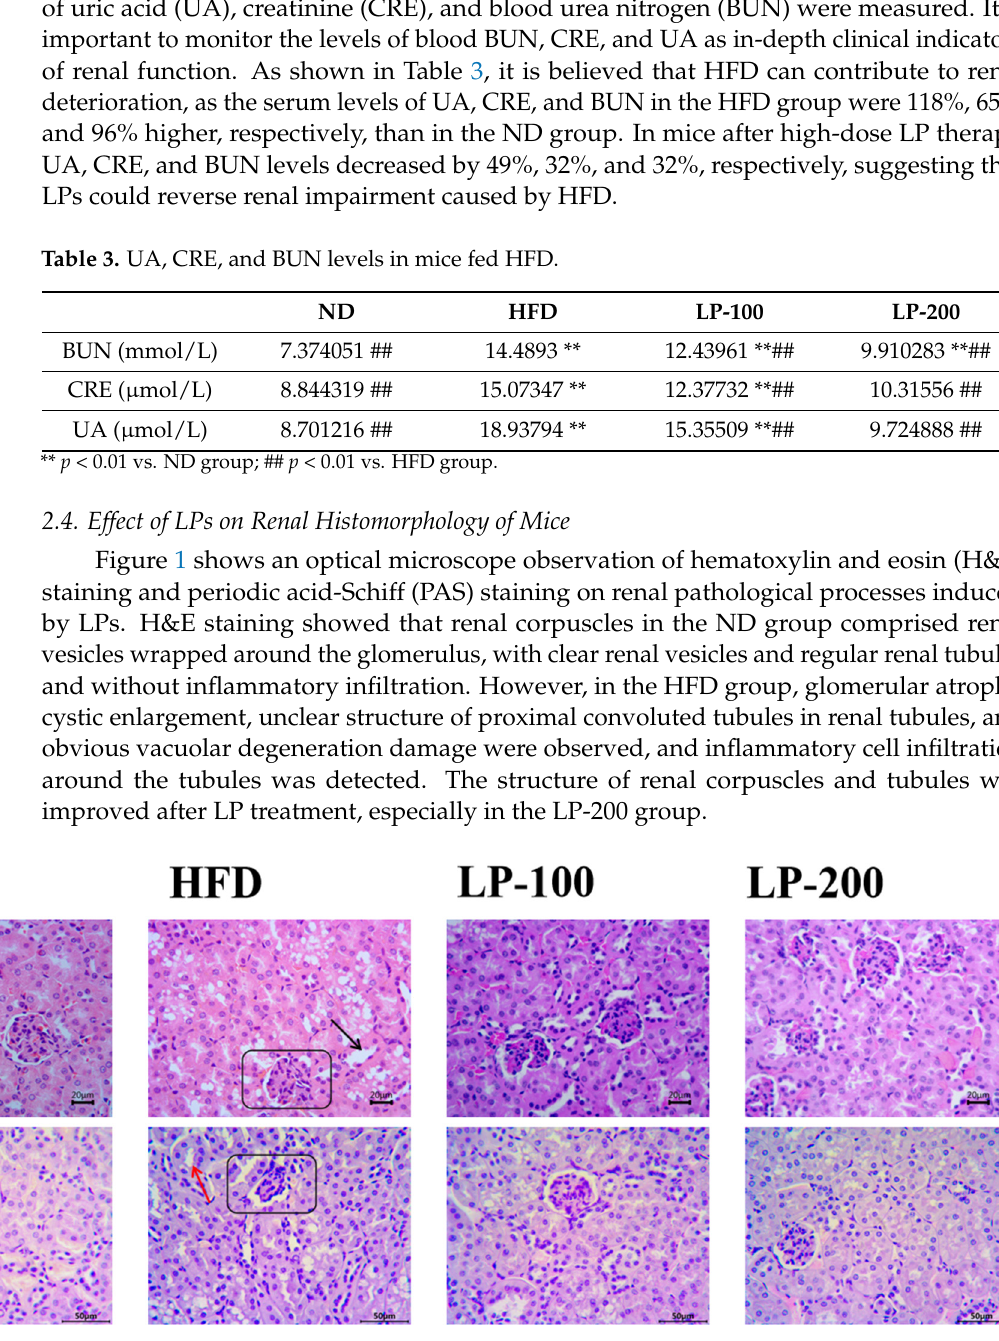
Figure 1. Effect of LPs on the morphological characteristics of kidney in HFD-fed mice. PAS trichrome and H&E staining were applied to kidney sections.